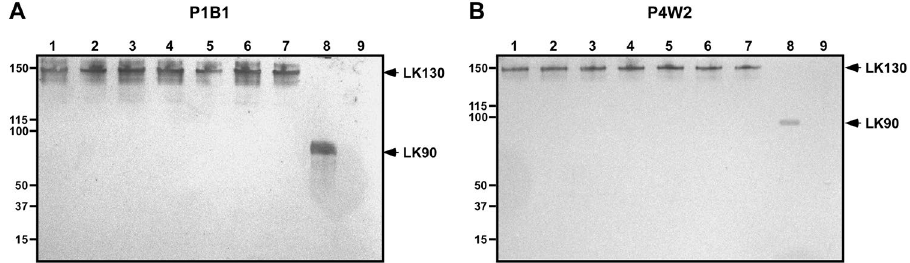
Figure 3. Specificity of the MAbs P1B1 and P4W2 for detection of leptospiral seovars. Heat extracted proteins from MACS leptospiral strains, E. coli , and recombinant LK90 were separated on SDS-PAGE and Western blotted with the indicated MAbs. Heat extracted proteins from L. interrogans serovars Autumnalis strain Akiyami (Lane 1), Bangkinang (Lane 2) and N2 (Lane 3), serovar Australis (Lane 4), serovar